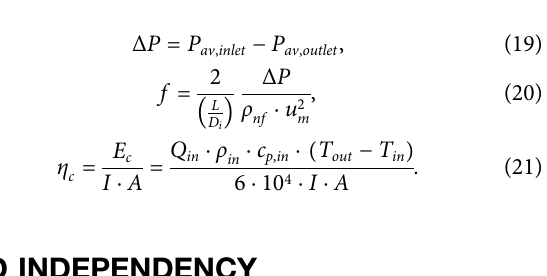
Frontiers in Energy Research |